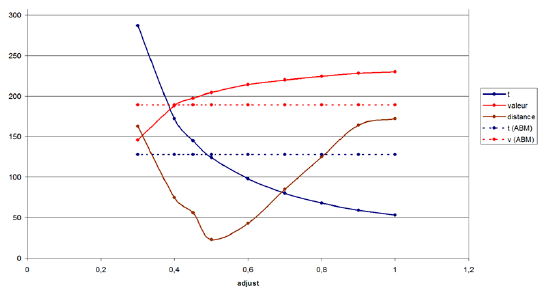
Figure 7. Adjust the beta parameter of SIR model to calibrate EBM with ABM result.